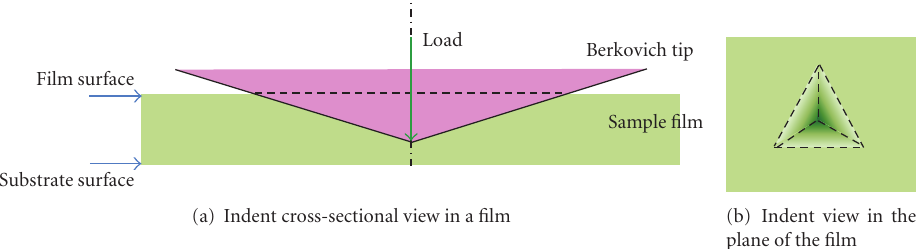
Figure 6: Diagram of an indent left by a Berkovich tip in a film.